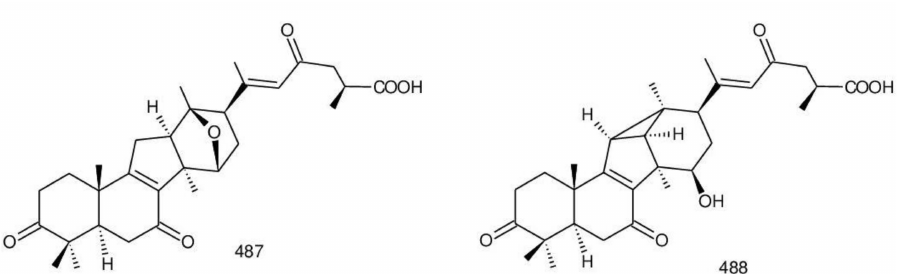
Figure 32. Chemical structures of ganoapplanic acid A ( 487 ) and ganoapplanic acid B ( 488 ) a s rearranged novel triterpenoids.